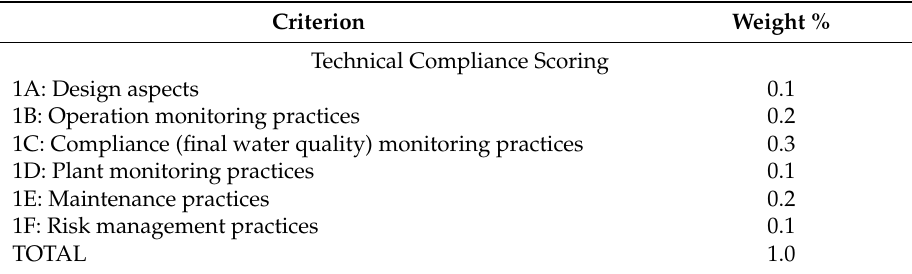
Table 2. Technical compliance assessment scoring